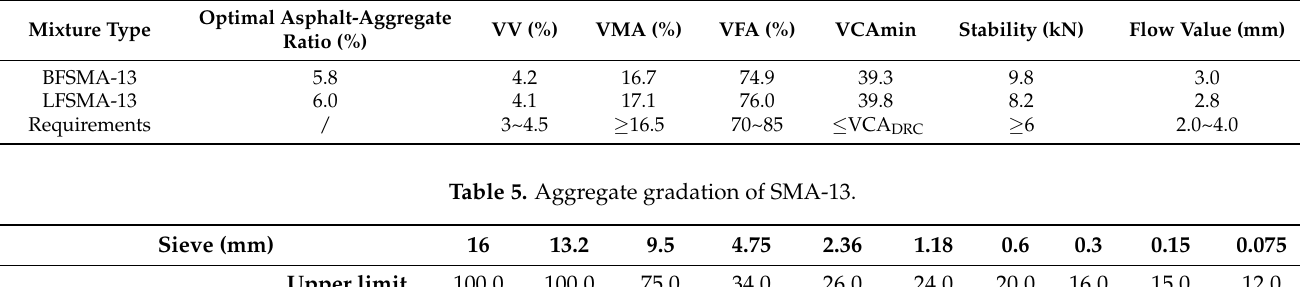
Table 4. Marshall design results of SMA-13.